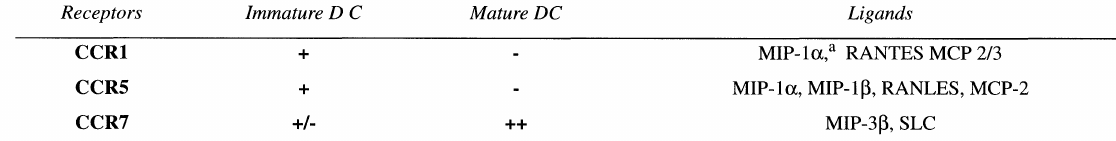
TABLE Switch of chemokine receptor expression during DC